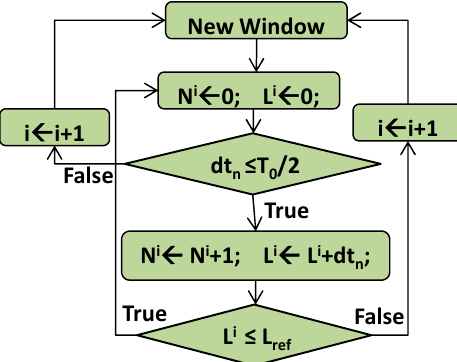
Figure 3. The algorithmic state machine (ASM) chart of activity selection algorithm.